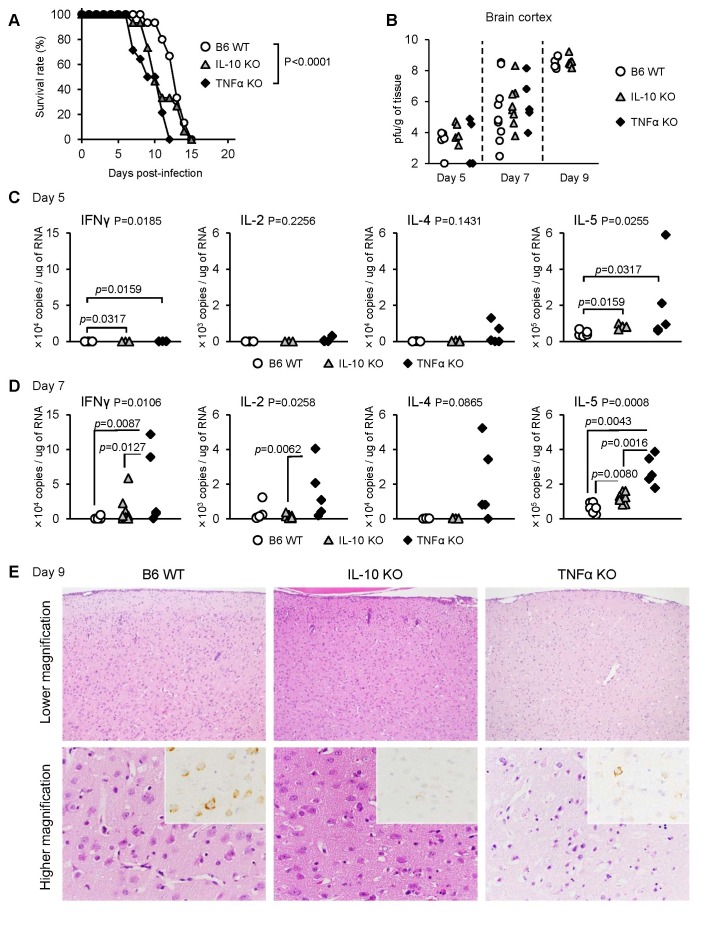
Mortality and pathogenicity of TNF-α and IL-10 KO mice infected with JaTH160.(A) Survival curves of IL-10 KO (n=15) and TNF-α KO (n=14) B6 mice following subcutaneous infections with 104 pfu of JaOArS982. WT B6 mice (n=15) show the same data of Figure 1B. P: Gehan-Breslow-Wilcoxon Test. (B) Viral loads in the brain cortex of WT (Day 5: n=5, Day 7: n=9, Day 9: n=8), IL-10 KO (Day 5: n=5, Day 7: n=8, Day 9: n=6) and TNF-α KO (Day 5: n=5, Day 7: n=5) mice following subcutaneous infections with 104 pfu of JaTH160 at 5, 7 and 9 days pi. Data of WT B6 mice at 5 and 9 days pi were same to Figure 1D. (C and D) mRNA levels of IFNγ, IL-2, IL-4 and IL-5 in the brain cortex of WT, TNF-α KO and IL-10 KO mice infected with 104 pfu of JaTH160 at 5 (C) and 7 (D) days pi. P: Kruskal-Wallis test, p: Mann Whitney test. (E) Histopathological features of WT, TNF-α KO and IL-10 KO mice infected with 104 pfu of JaTH160 at 9 days pi. JEV antigens were detected using E-protein specific JEV antibody (insets). Each experiment represents four, five and six mice of WT, TNF-α KO and IL-10 KO mice, respectively. The B6 WT and IL-10 KO mice showed severe inflammatory reactions in the brain cortex. On other hand, the TNF-a KO mice exhibited acute necrotic changes with slight inflammatory reactions in the brain cortex.